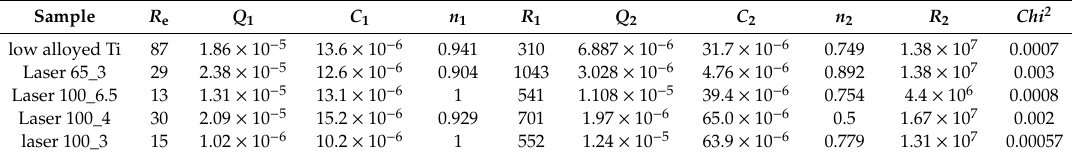
Table 4. Values of fitted parameters of the equivalent circuit as a function of applied potential at 1 h